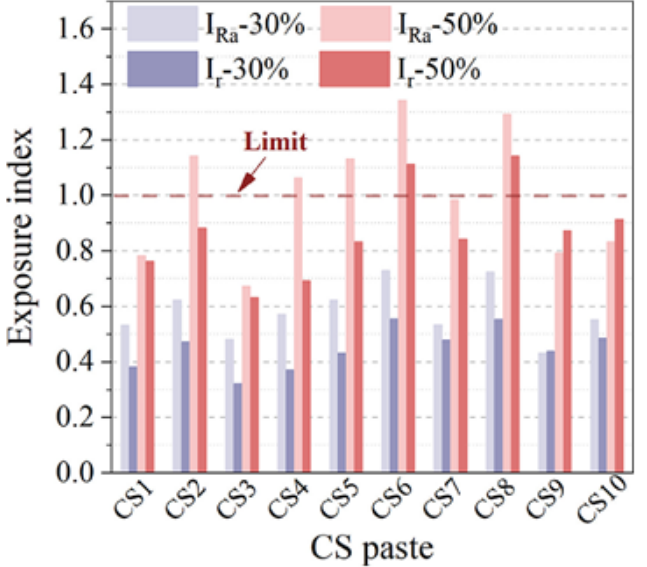
Figure 16. Radioactivity of the mortar containing CS (IRa: internal exposure index; Ir: external ex − posure index) [27].